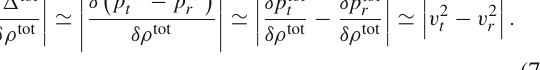
Fig. 10 The behavior of stability factor ( v 2 r − v 2 t ) versus radial coor- dinate r / R by taking the numerical values of the constants a = 0 . 003, b = 0 . 0000053, β = 1 . 1, and γ = − 0 .